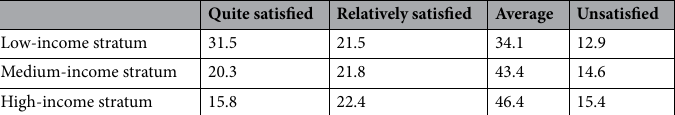
Table 6. Overall satisfaction of residents to food safety Unit: